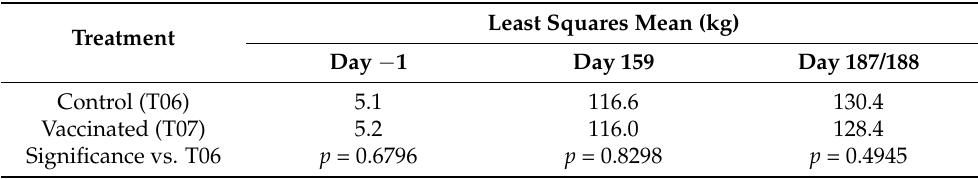
Table 8. Least squares means and significance values for body